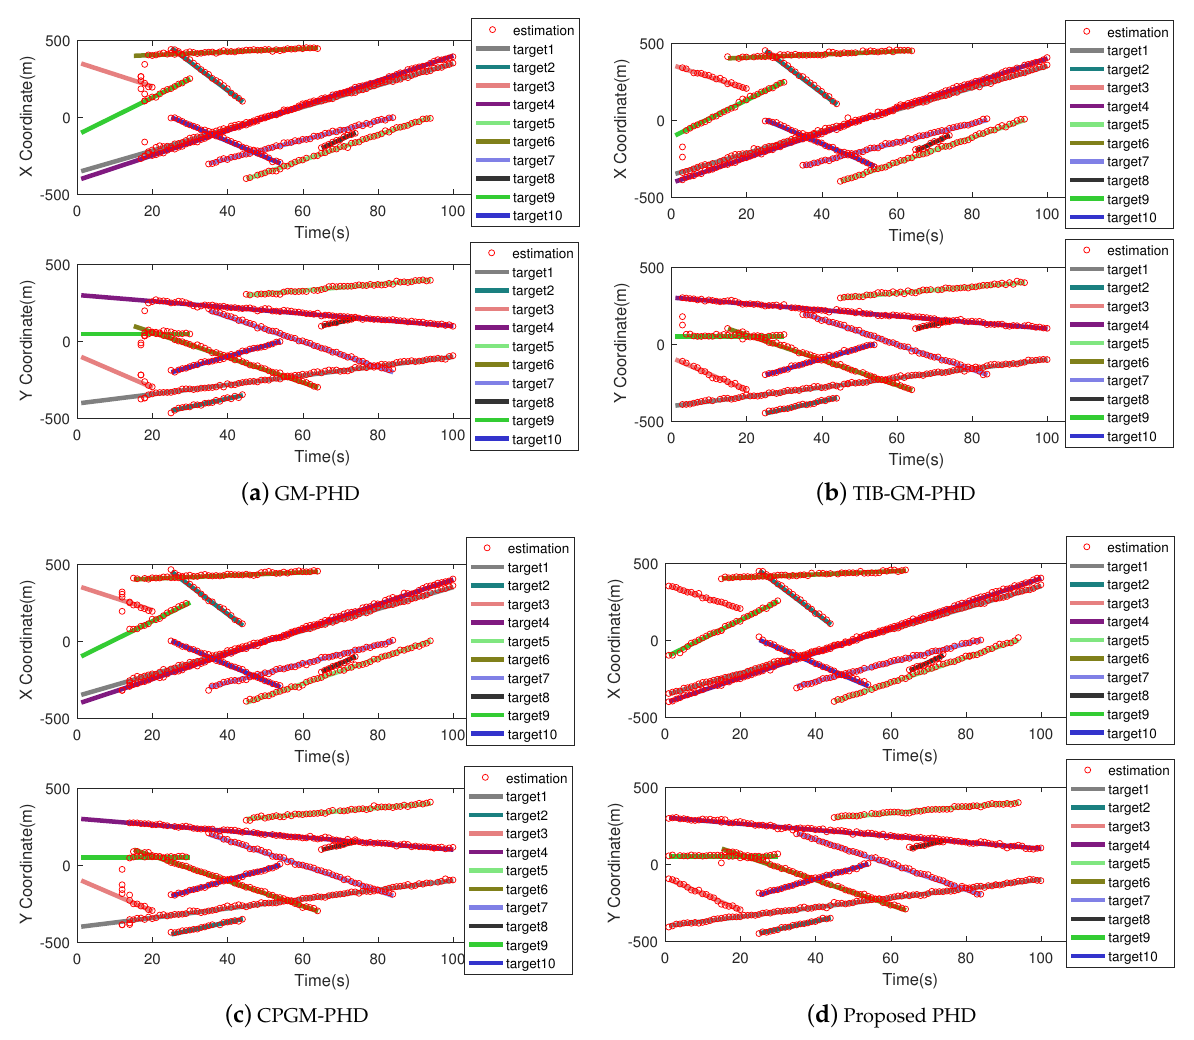
Figure 5. The position estimation of GM-PHD, TIB-GM-PHD, CPGM-PHD and Proposed PHD in the birth